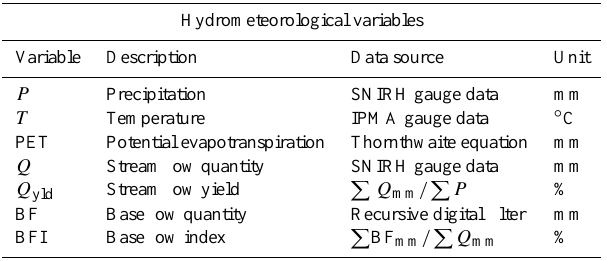
Table 2. Summary of hydrometeorological